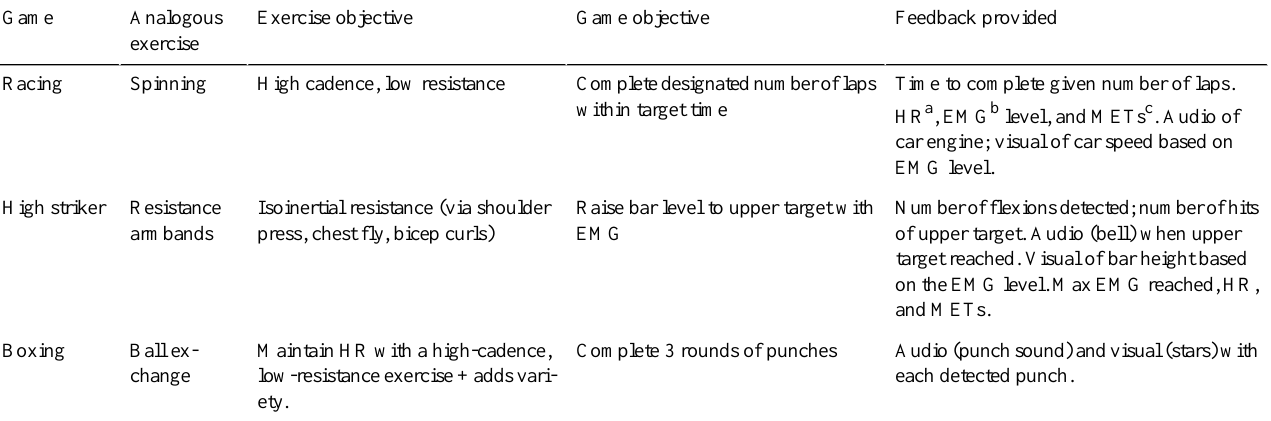
Table 2. Conceptual design of Workout on Wheels-Mobile exergames.